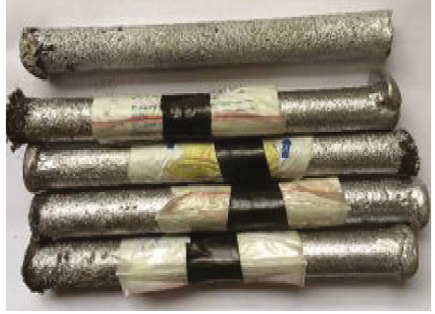
Figure 1: Reinforced aluminium 6061